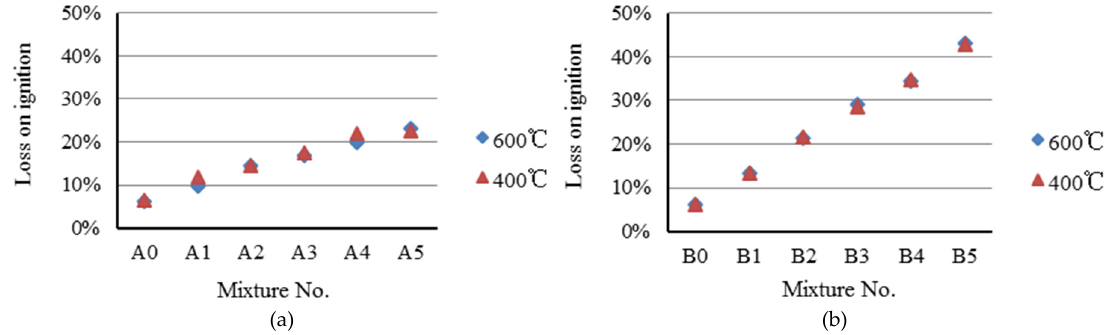
Figure 5. Loss on ignition of paper sludge lightweight aggregates. ( a ) A series; ( b ) B series.